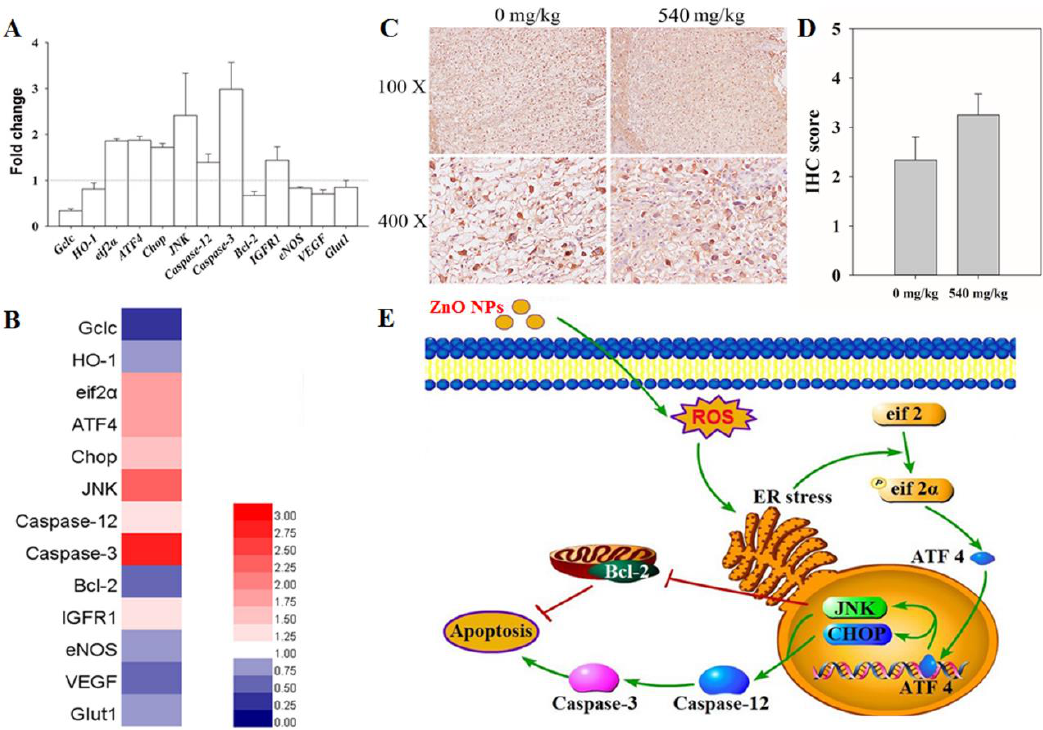
Figure 4. Gene expression after maternal oral exposure to ZnO NPs. ( A ) Relative gene expression of placenta from the 540 mg/kg ZnO groups are presented as the fold change, and fold change = 2 -ΔΔCt with GADPH as the reference gene for all test groups (n = 6). ( B ) Hotmap represents a different gene transcription in the placenta. ( C ) Immunohistochemistry (IHC) results show Jun N-terminal kinases (JNK) expression in placenta among the control group and 540 mg/kg groups. ( D ) The IHC score of JNK. (E) Schematic drawing of the proposed mechanism for ZnO NPs that induce placenta injury.